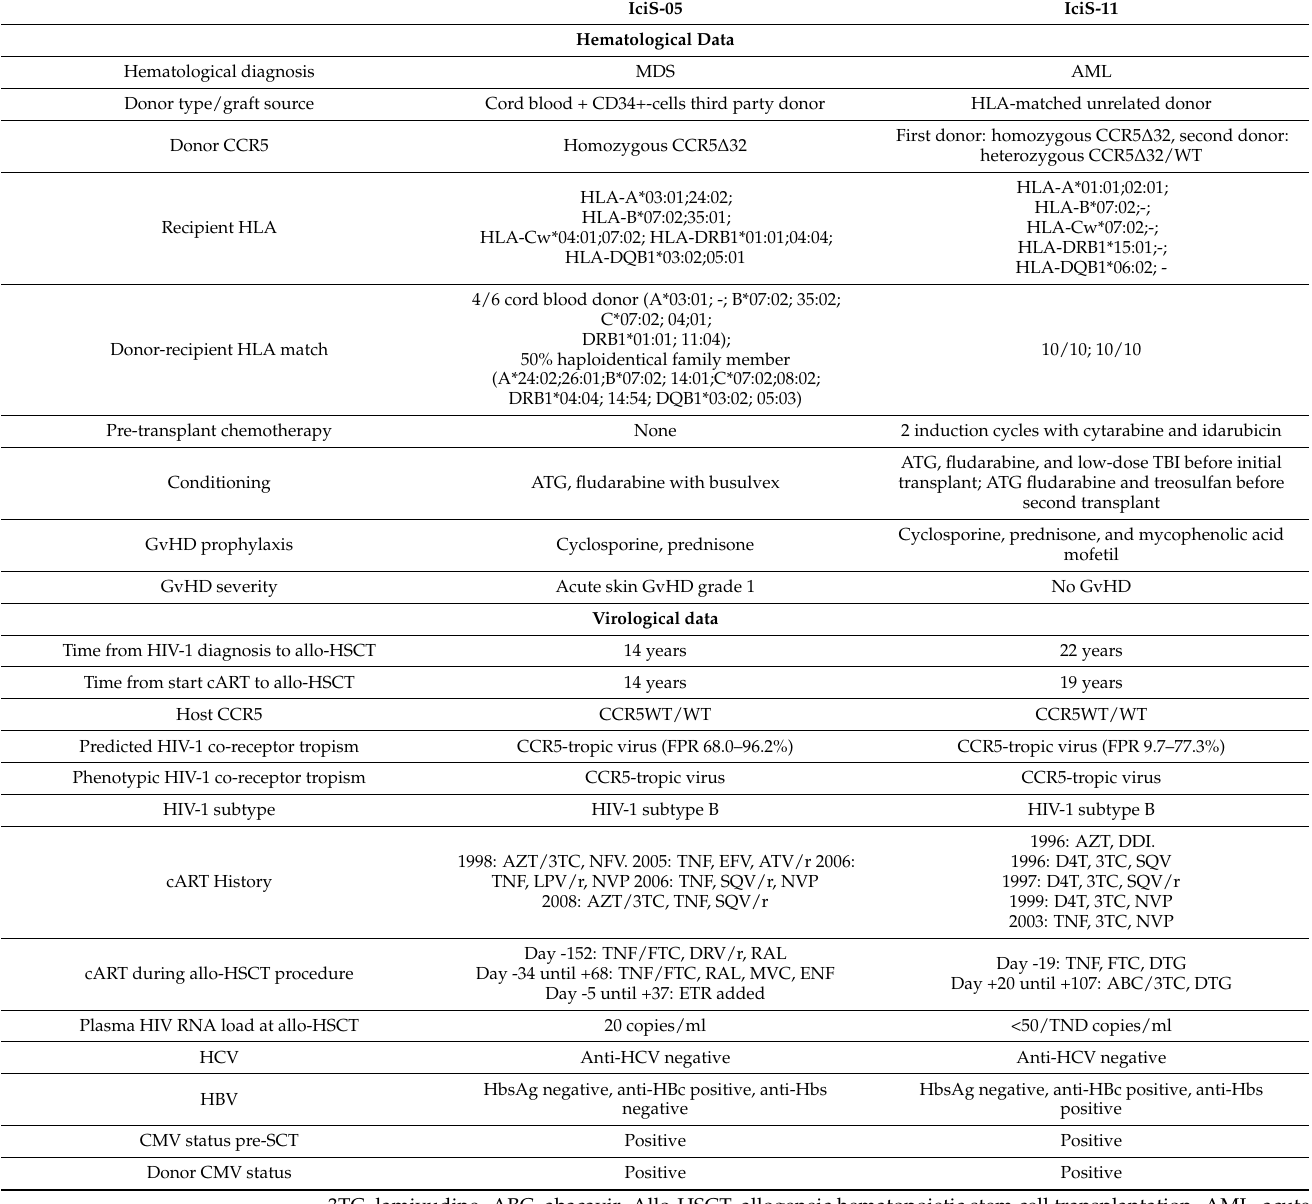
Table 1. Baseline clinical characteristics of